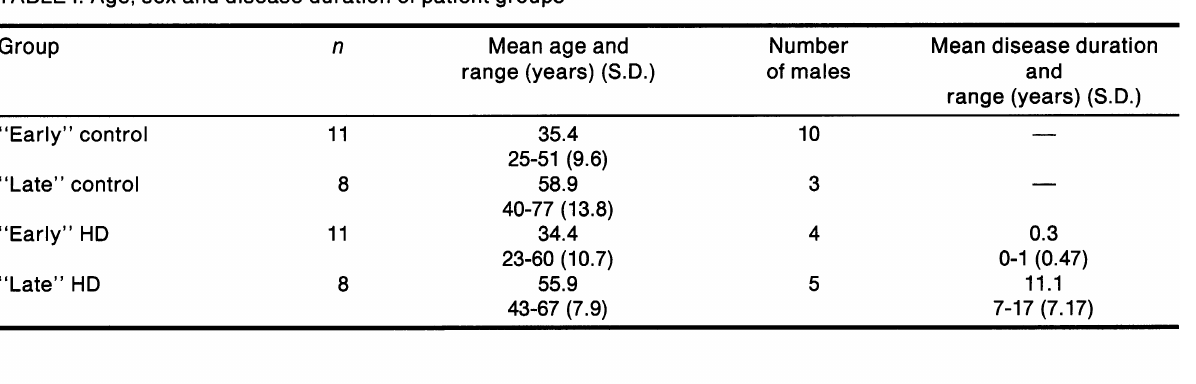
and range (years) (S.D.) of males range (years) (S.D.)